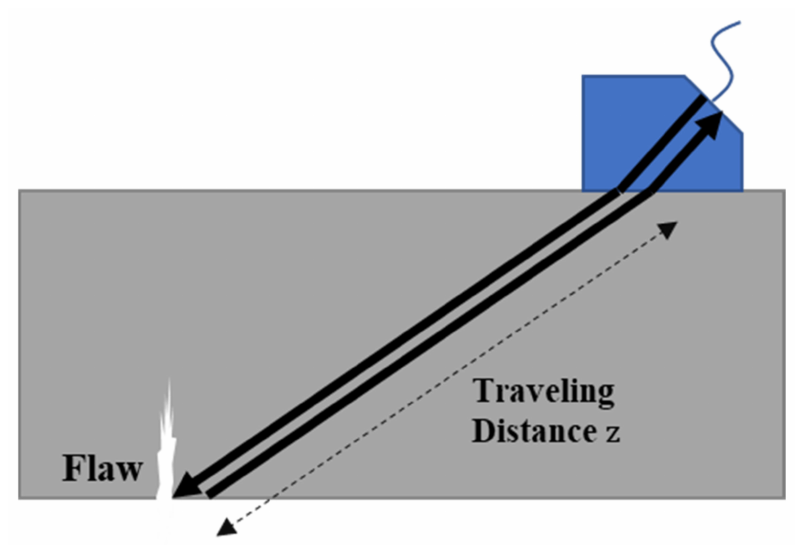
Figure 5. Schematics of the experimental setup to obtain a flaw signal in the